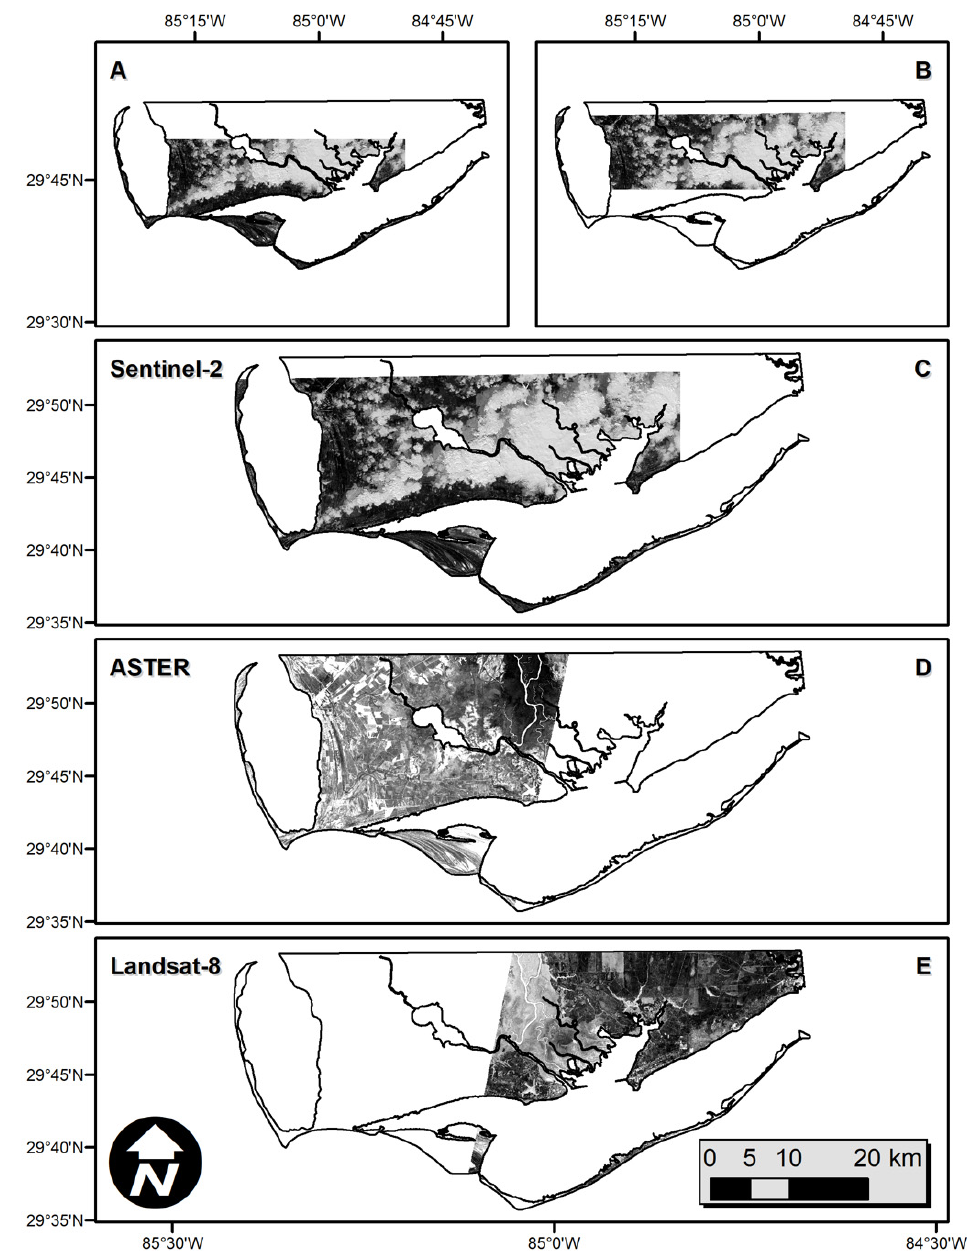
Figure 3. Issues disrupting long term continuous NDVI coverage. ( A – C ) Sentinel-2A August 2015, overlapping cloudy scenes from the same month merged. ( D ) ASTER May 2018 and ( E ) Landsat 8 February 2018, no adjacent scenes present during those months.